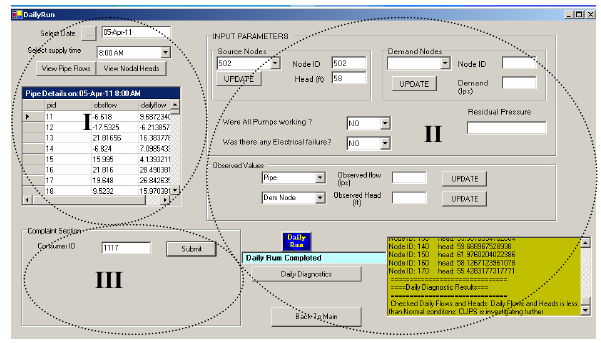
Fig. 8. Different modules of Daily Run Module